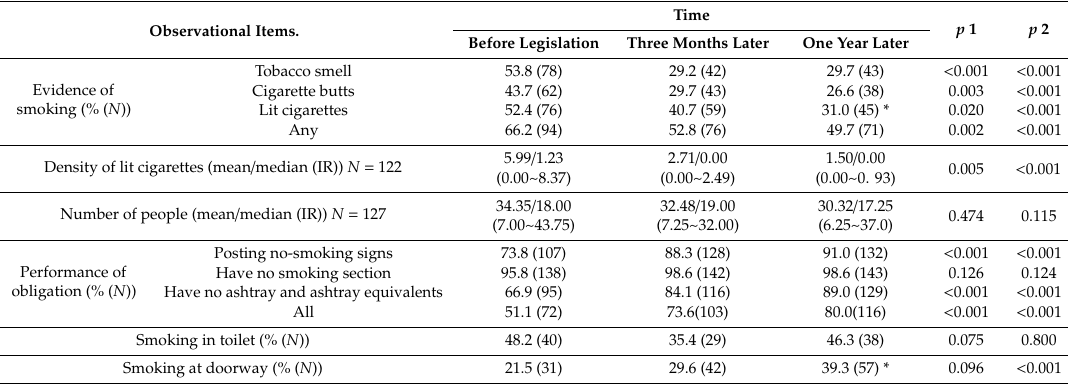
Table 2. The comparation of observational items before and after